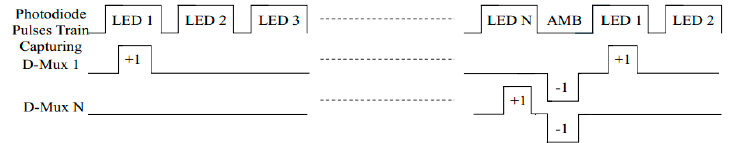
Figure 4. Schematic diagram of time switching in multiplexed illumination of LEDs and demultiplexed signals from a photodiode.